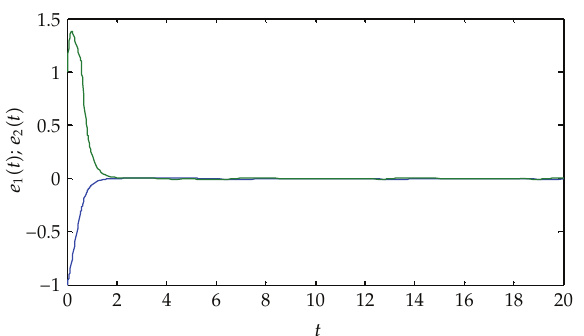
Figure 3: Synchronization errors of systems (cid:2) 3.1 (cid:3) – (cid:2) 3.7 (cid:3) with β (cid:9) − 1.